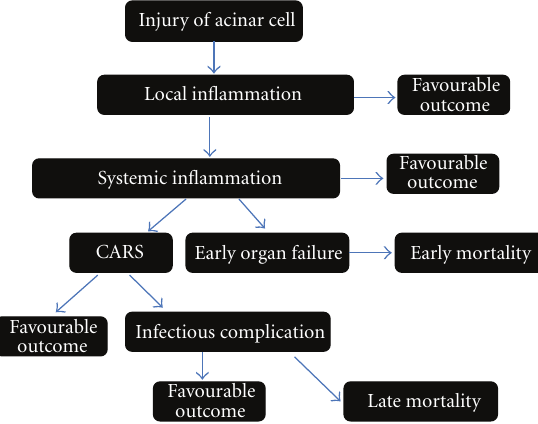
Figure 1: Inflammatory response in acute